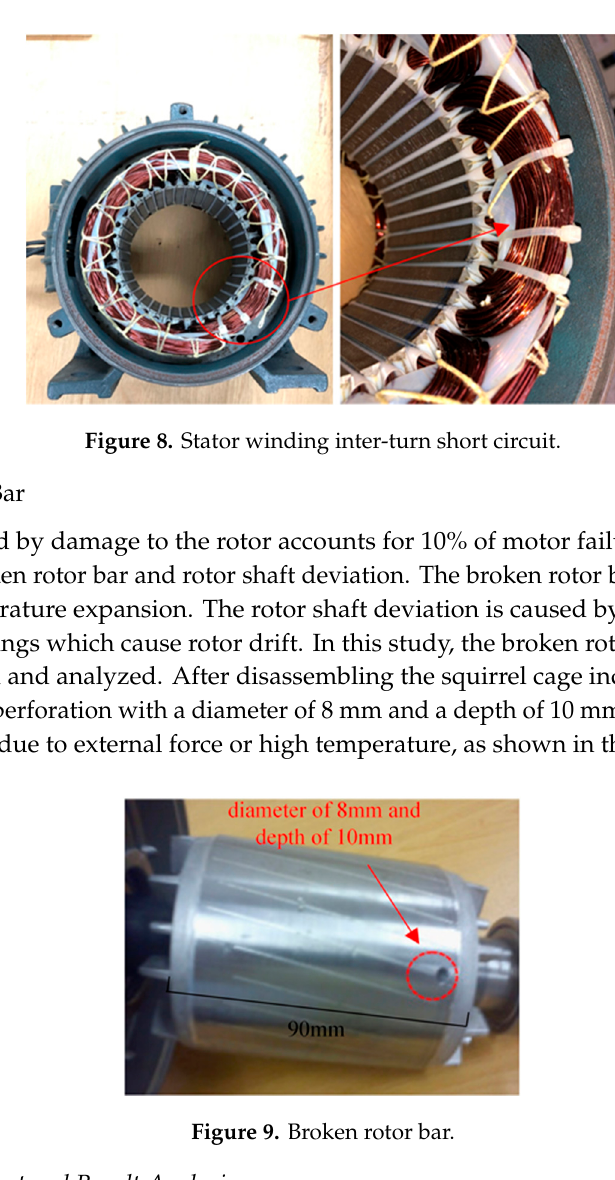
Figure 7. Schematic diagram of bearing inner ring defect. 4.2.2. Stator Winding Inter-Turn Short Circuit The failure is caused by damage to the stator accounts for 35% of motor failure cases. The main failure type is stator coil insulation failure. The insulation damage of the stator coil is caused by: (1)